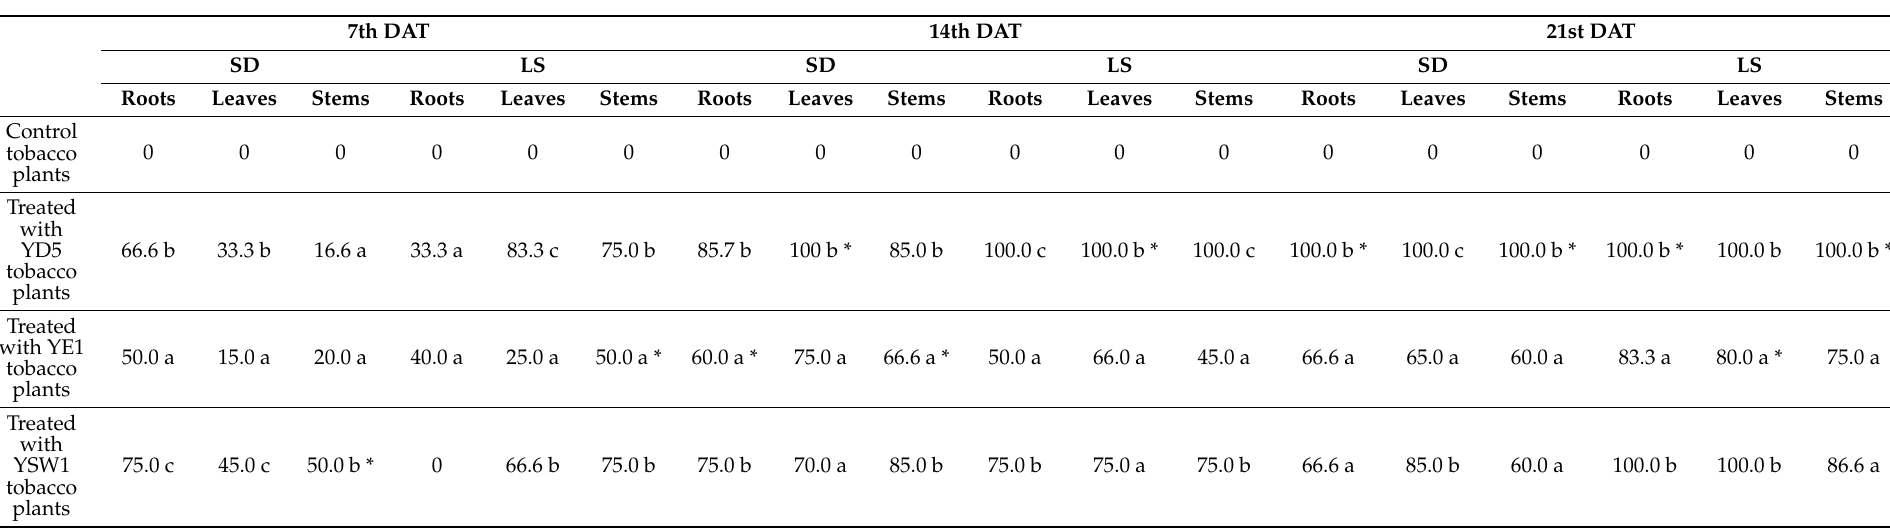
Table 2. Percentage of colonization of tobacco plants on day 7 DAT, 14 DAT, and 21 DAT with yeast strains imported by direct inoculation into the soil drench and leaf spraying. 7th DAT 14th DAT 21st DAT SD LS Leaves Stems Roots Leaves Stems Roots Leaves Stems Roots Leaves Stems Roots Leaves